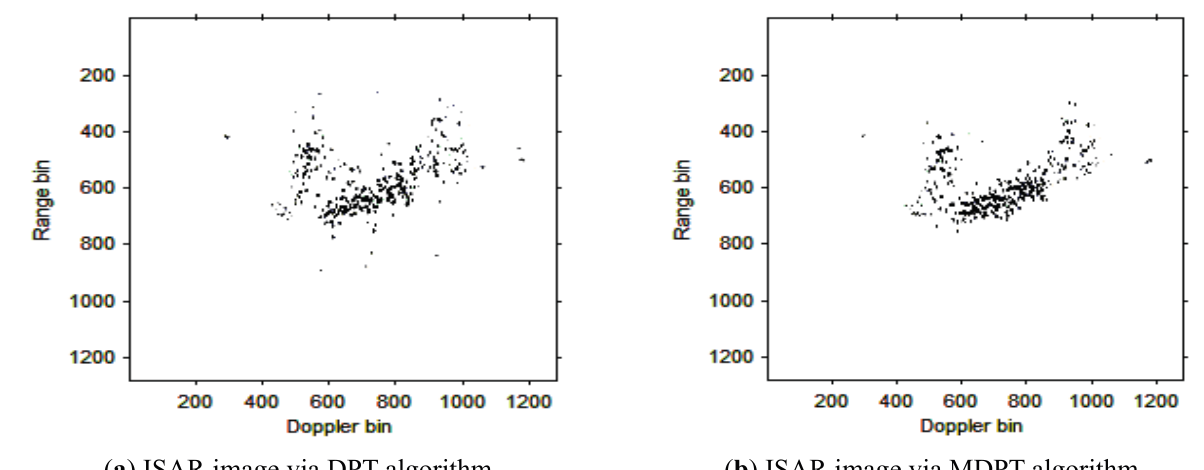
Figure 18. ISAR images at time t = 0.96 s based on DPT and MDPT